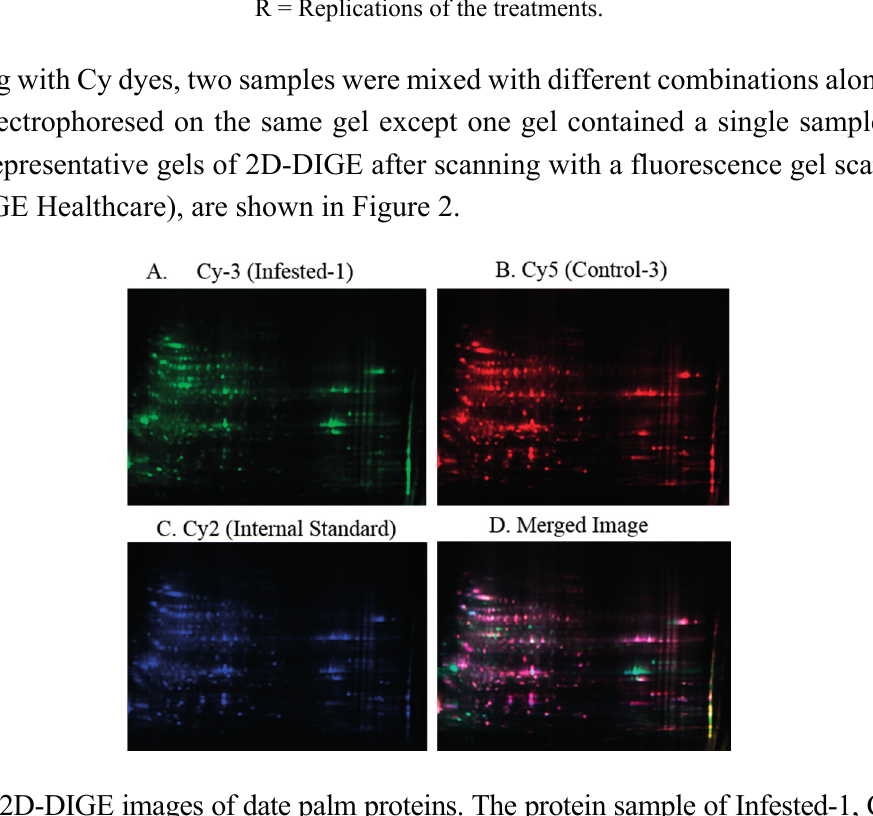
Figure 2. 2D-DIGE images of date palm proteins. The protein sample of Infested-1, Control-3 and internal standard (pooled of all the samples) are individually labeled with Cy dyes, mixed together and separated by 2D-DIGE followed by image scanning. ( A ) Image of date palm infested sample and labeled with Cy3 dye; ( B ) Image of date palm control sample labeled with Cy5 dye; ( C ) Image of date palm sample pooled from all and labeled with Cy2 dye; and ( D ) Overlay gel of infested, and control samples along with internal